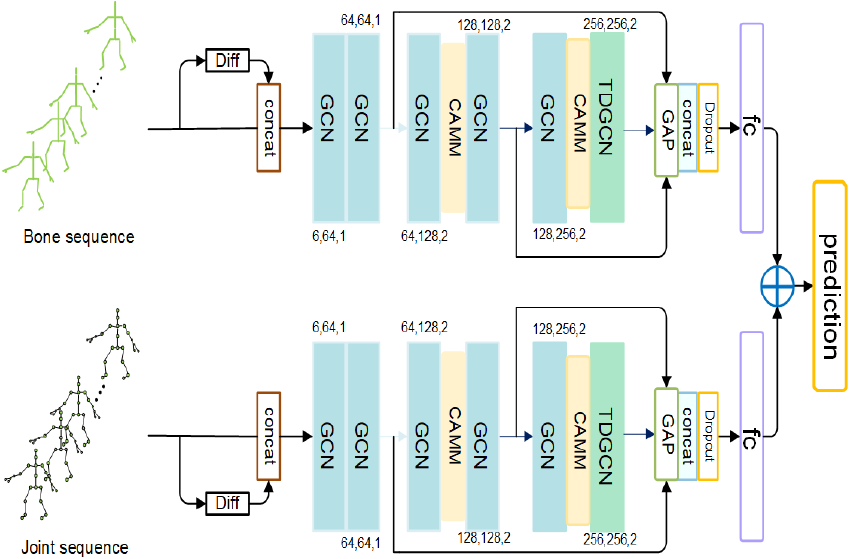
Figure 1. The illustration of our proposed SGCN architecture. GCN is the spatial-temporal graph convolution block. Its three numbers represent the number of input channels, output channels, and the temporal stride. CAMM is the channel adaptive merging module. TDGCN is the spatial- temporal graph convolution block with temporal dilated convolution. GAP means global average pooling. Features from different layers are combined to get a steady representation of the